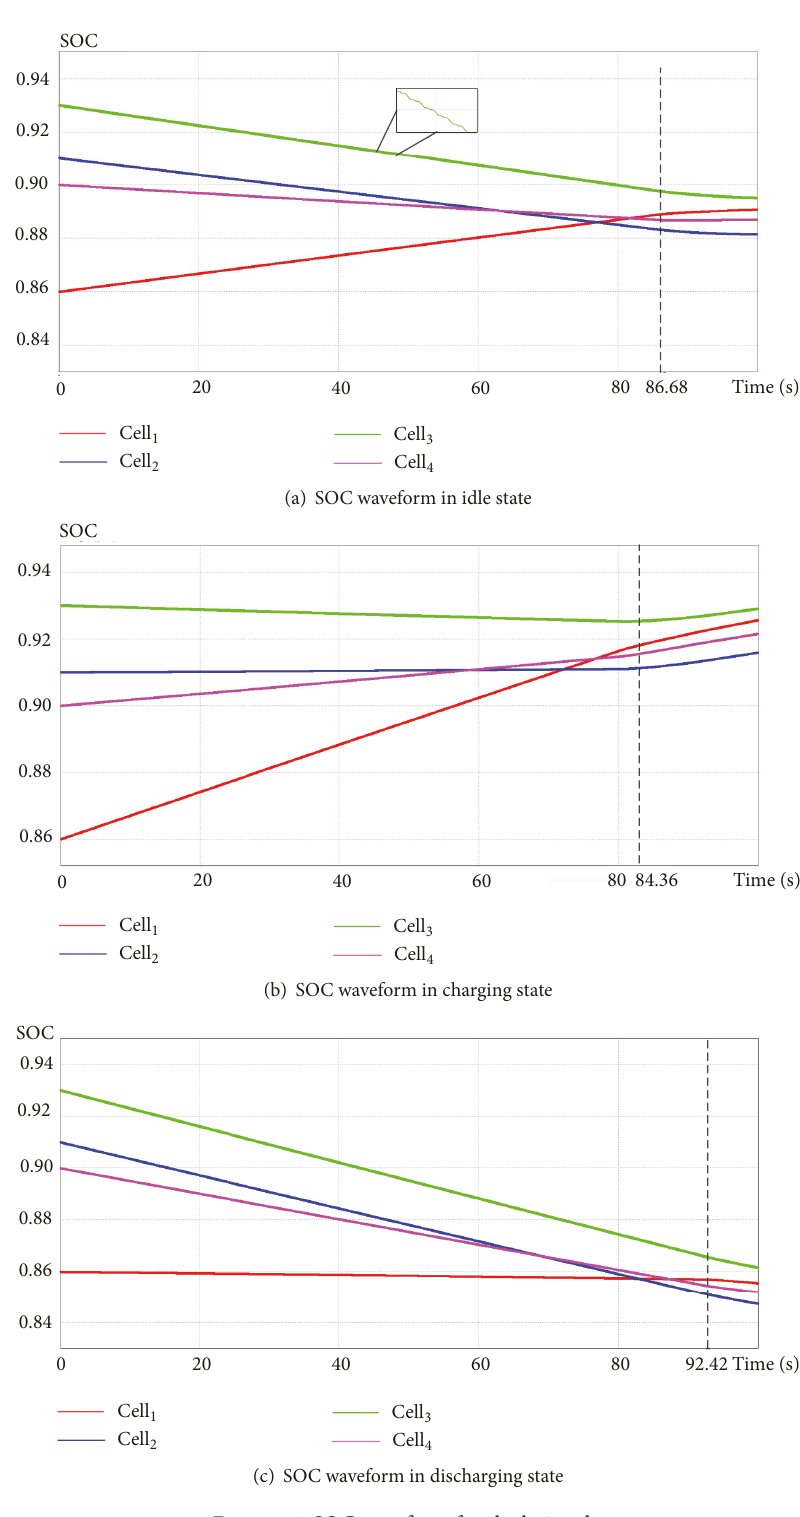
Figure 14: SOC waveform for clock